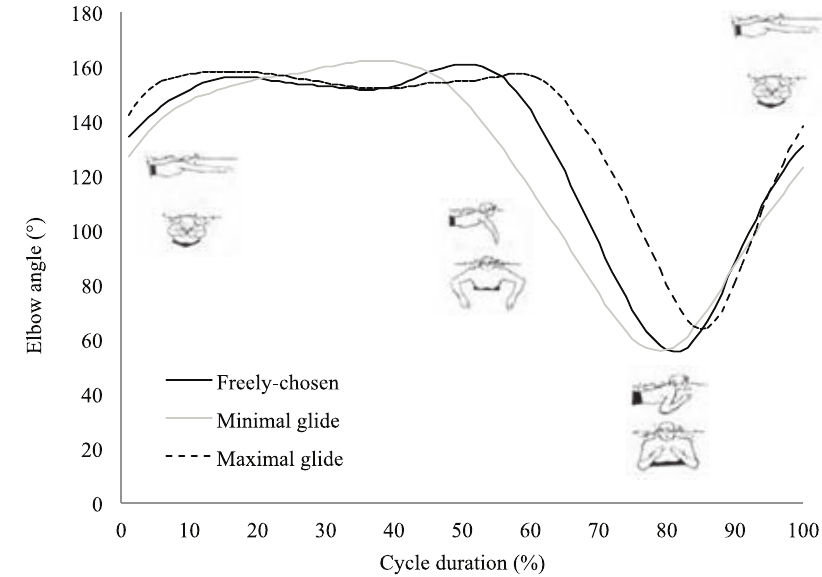
Figure 2. Elbows angle (mean of six cycles from all participants) for the three coordination conditions. One stroke cycle corresponded to the period from one maximal knee flexion (0%) to the next maximal knee flexion